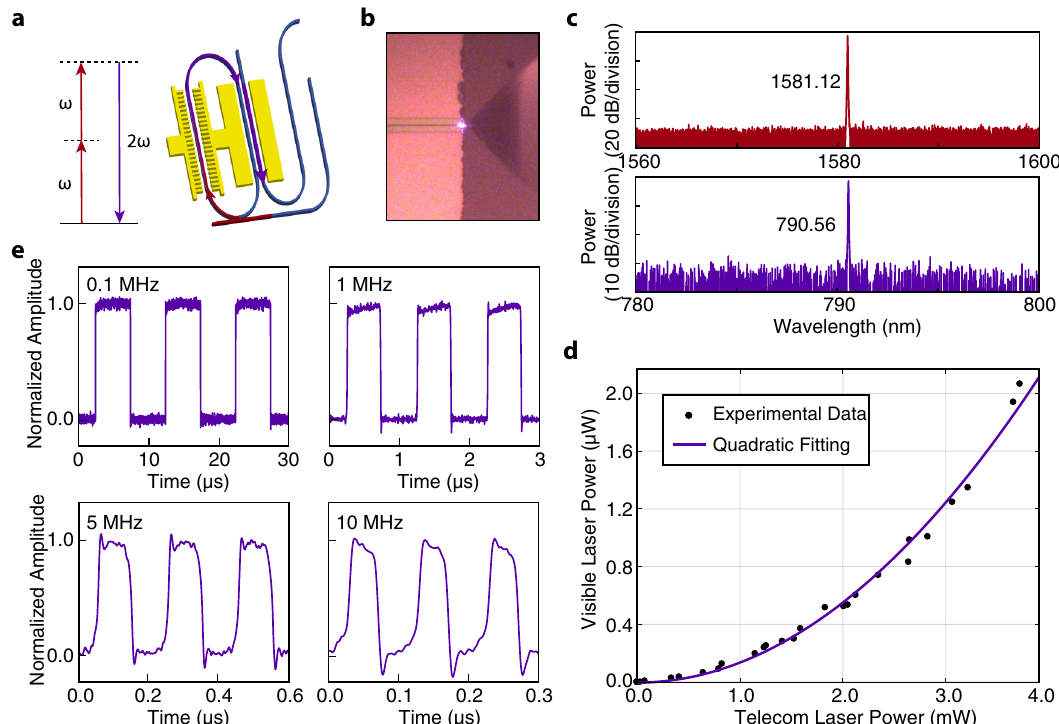
Fig. 4 | Performance of the dual-wavelength laser. a Schematic of the SHG pro- cess implemented in the resonator. b Optical microscope image of the produced SHGlightattheoutputfacetofthelaserchip. c Opticalspectraofthefundamental- frequency lasing mode (top) and the up-converted light at the second harmonic